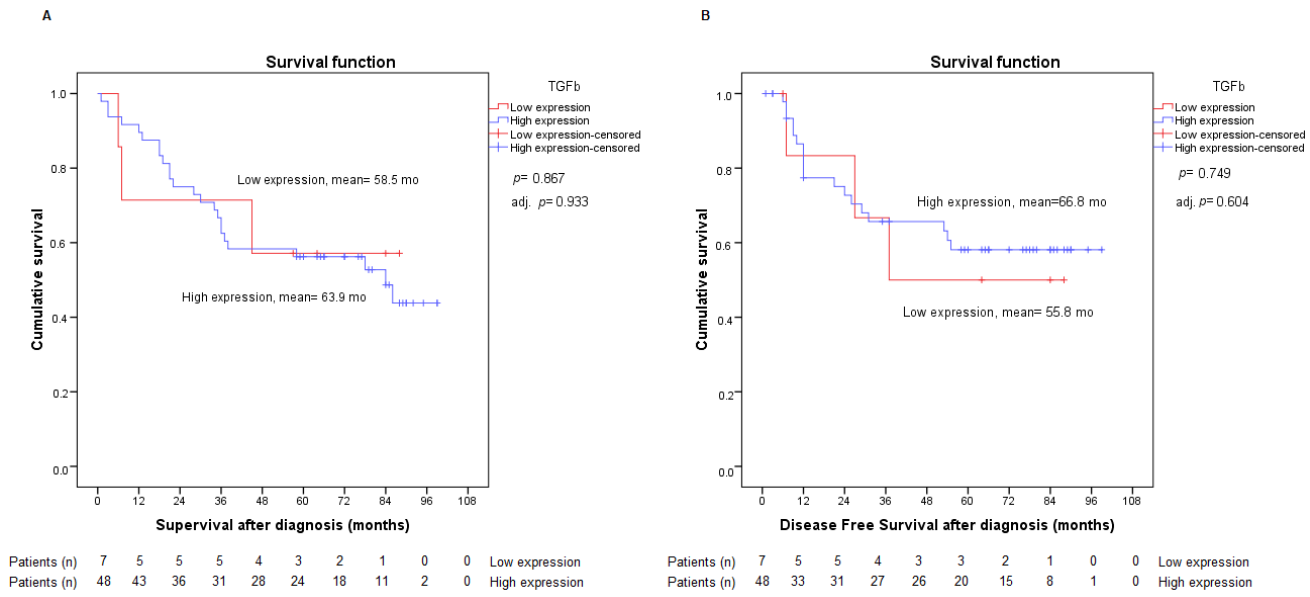
Figure 5. Analysis of overall survival ( A ) and disease-free survival ( B ) according to low or high TGF- β expression. Adj. p : p -value from Cox regression model adjusted by stage.